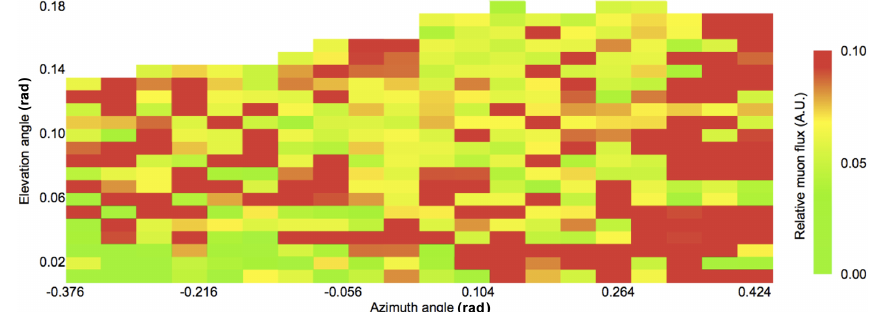
Figure 5. Angular distribution of the relative muon flux observed at Position B. The horizontal and vertical bin widths are respectively 40 and 8mrad. The azimuthal distribution of the relative muon flux was normalized to the total number of muons counted at each elevation angle.